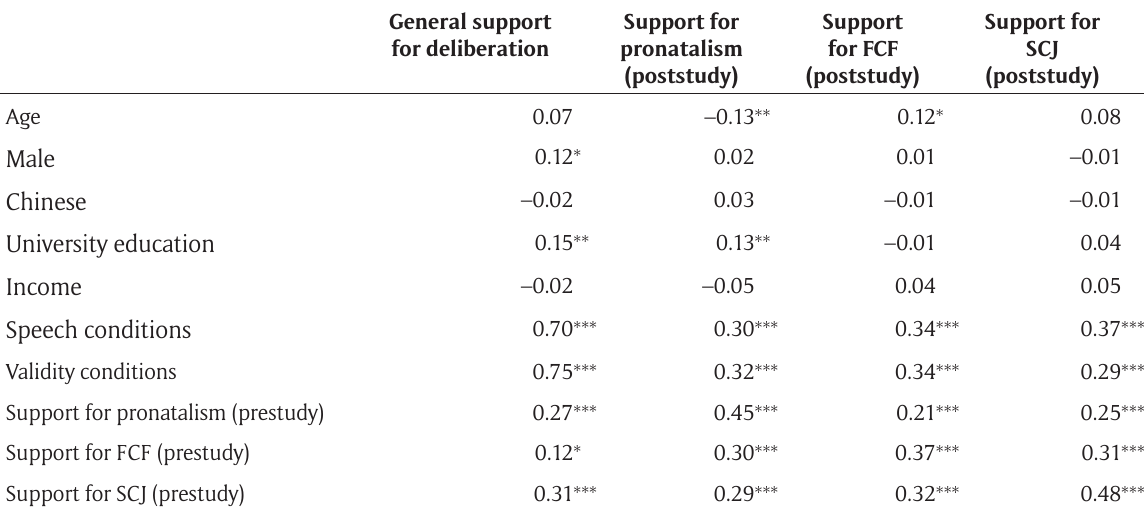
Table 2: Zero-order correlations between